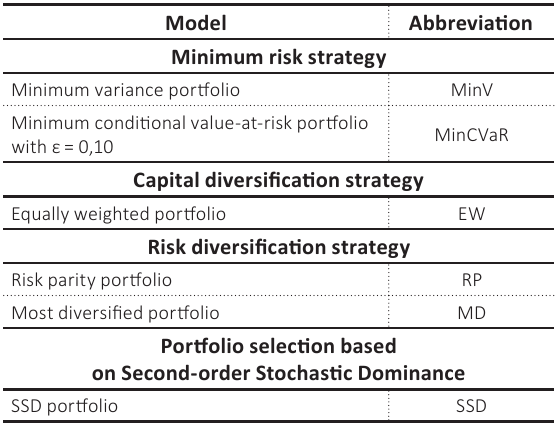
Table 1. List of portfolio